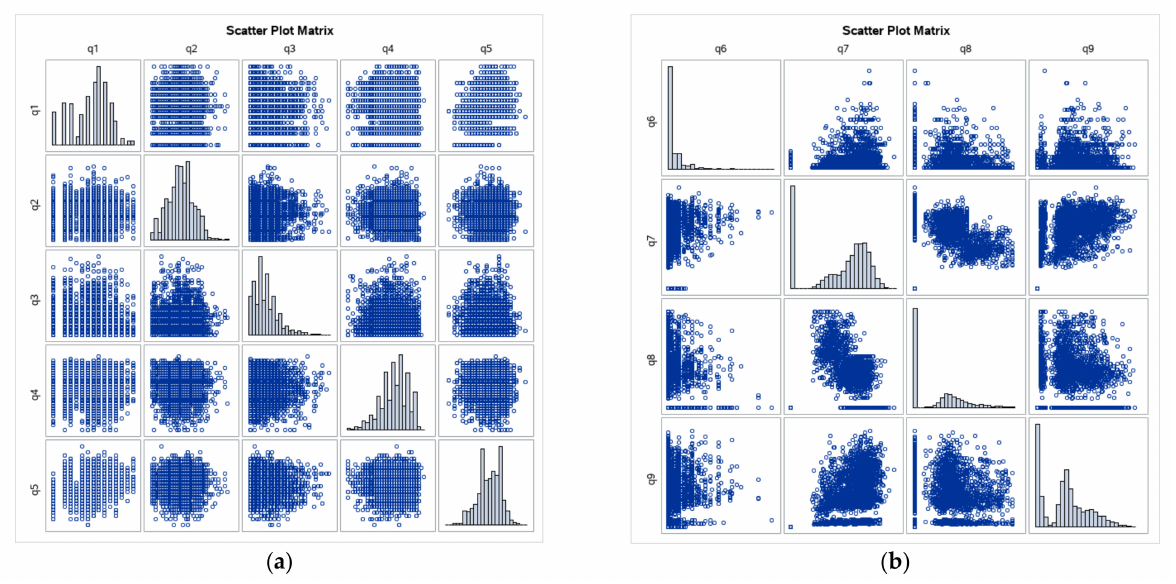
Figure 3. Scatter plot and distribution of variables ( a ) q1–q5, ( b ) q6–q9 of the post-trial data set. The pre-trial variables were closer to the normal distribution than the post-trial vari- ables. Thus, the logarithm function could be applied to the post-trial variables. Outliers generally decreased the performance of CFA. Therefore, the values were grouped into normal and outliers as in Figure 4.